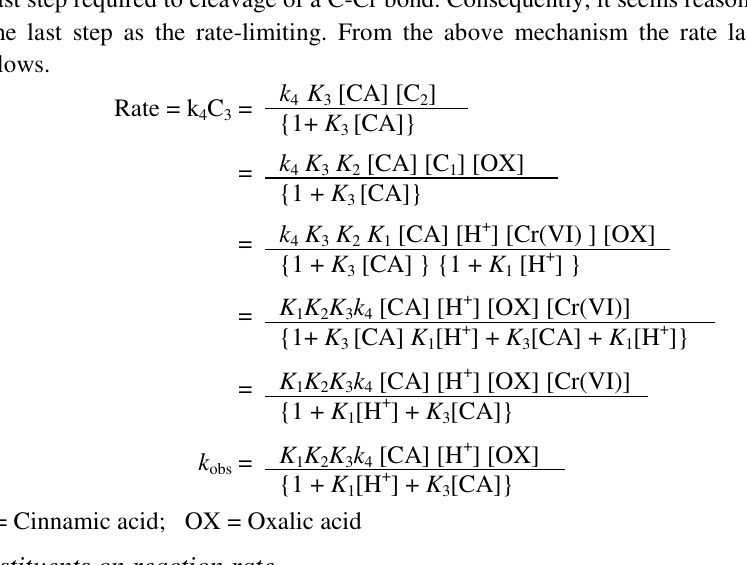
/T) versus 1/T obs